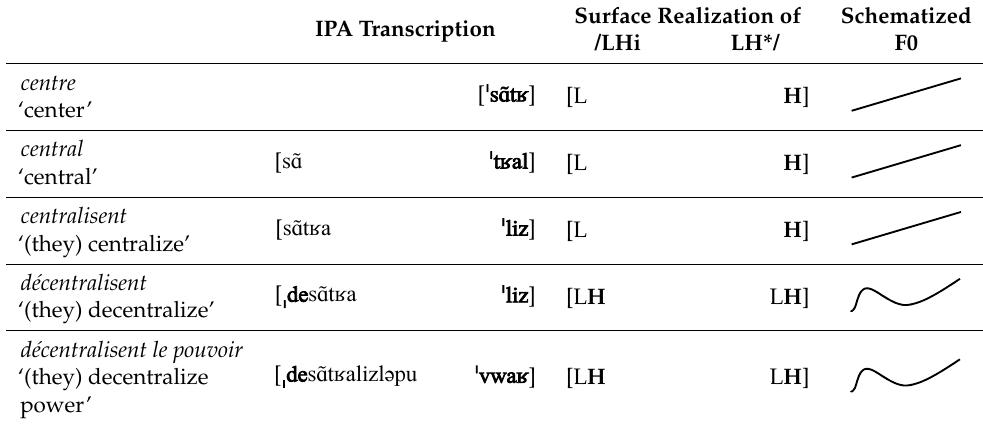
Table 1. Realizations of the French AP (Delais-Roussarie et al. 2015, p. 70). Surfacing high tones corresponding to prominent syllables are highlighted in bold.